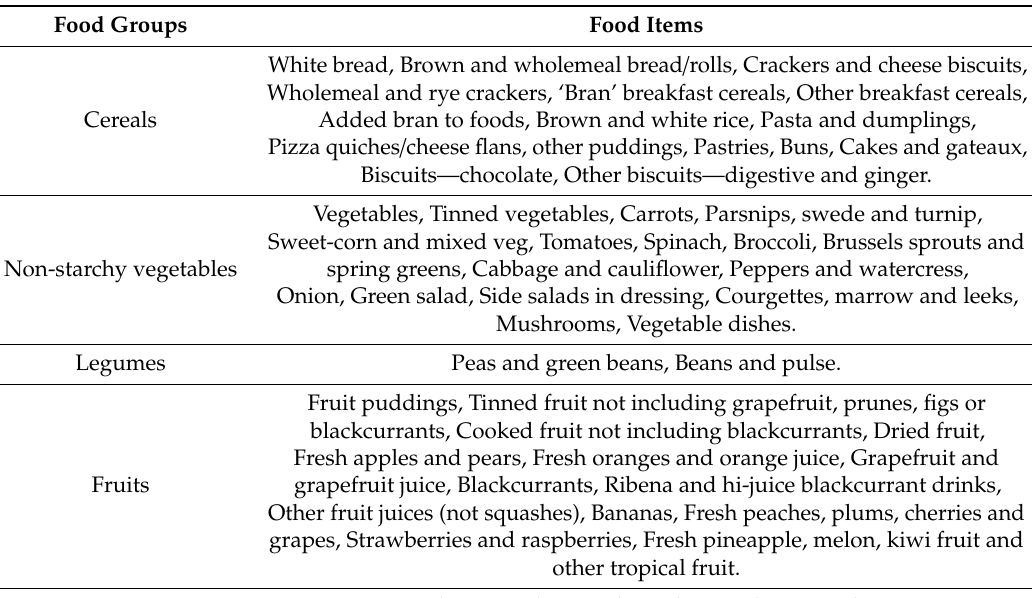
Table A1. Classification of food items according to nutrient